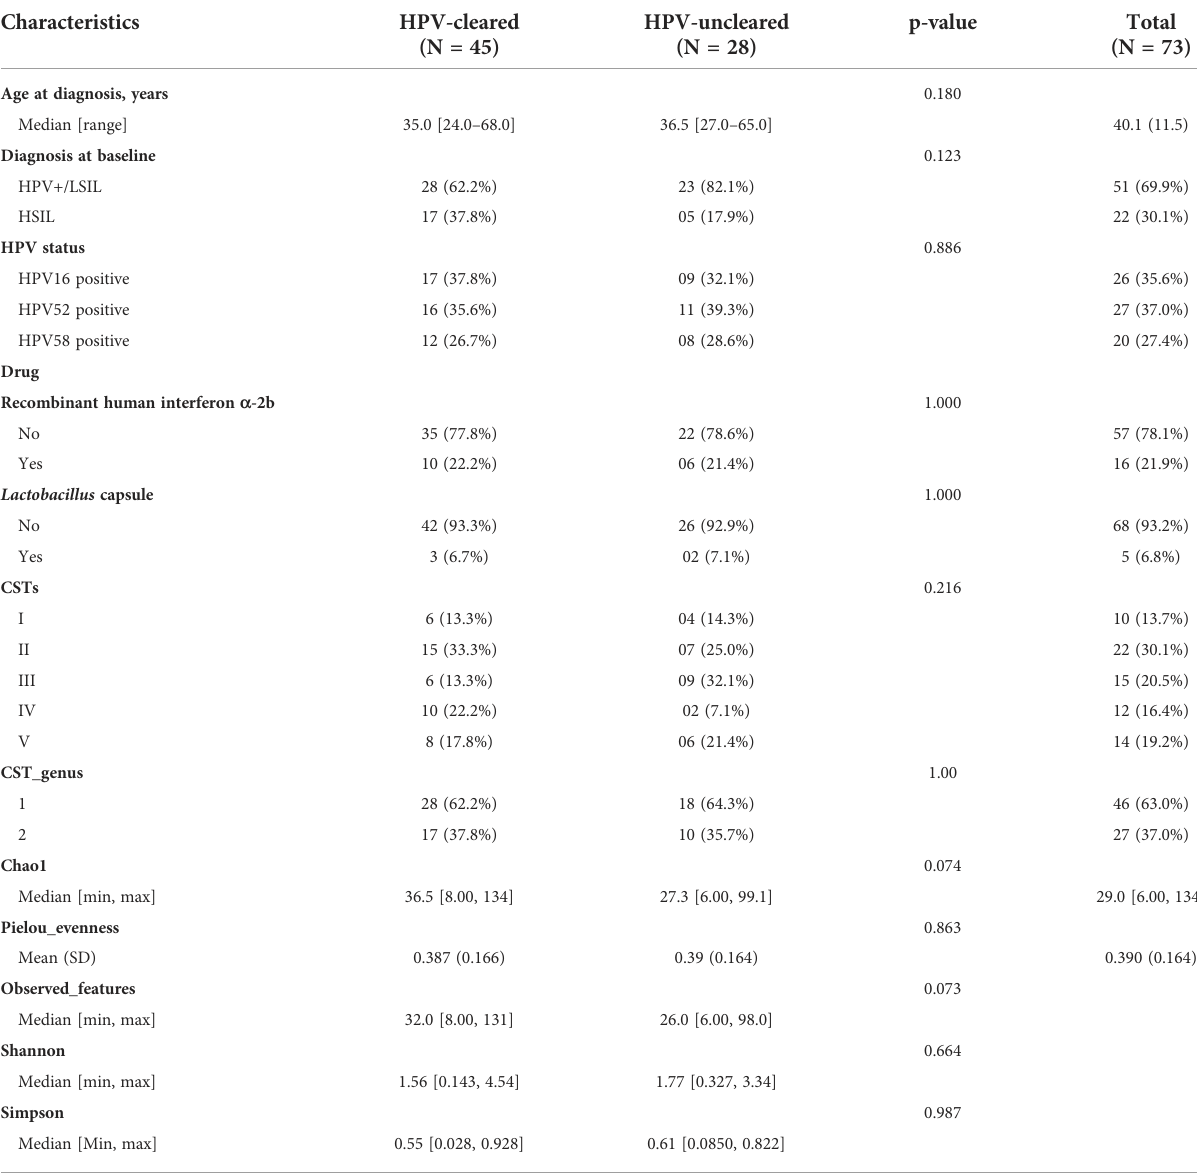
TABLE 1 Clinical characteristics and outcomes of participants in the study.